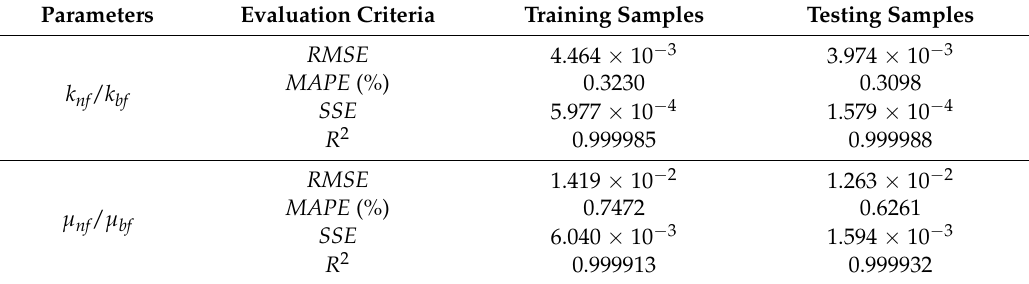
Table 5. Performance evaluation of the RBF neural network for the training and testing